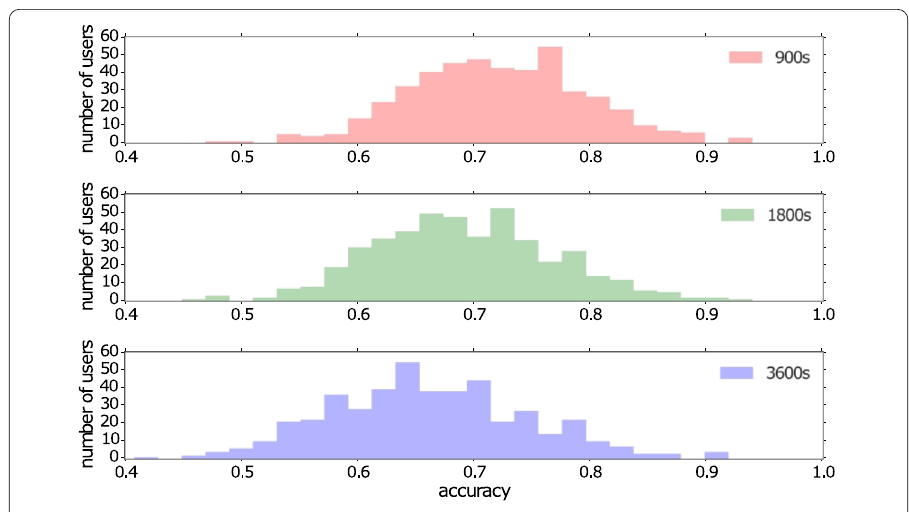
Figure 4 Effect of temporal sampling of the accuracy for the Markov model in the next-cell formulation. Each panel shows a different temporal bin resolution: 900 s, 1800 s and 3600 s. Decreasing the temporal resolution in this problem formulation increases the accuracy, since there are more